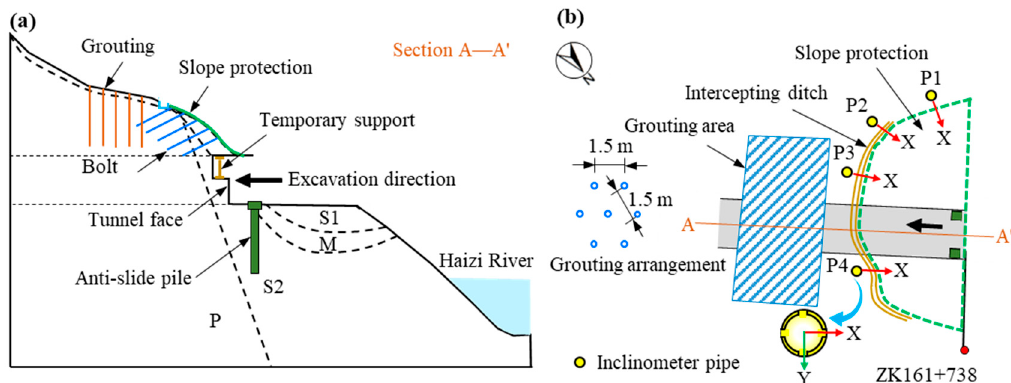
Figure 7. Layout of treatment measures. ( a ) Vertical section; ( b ) vertical view.